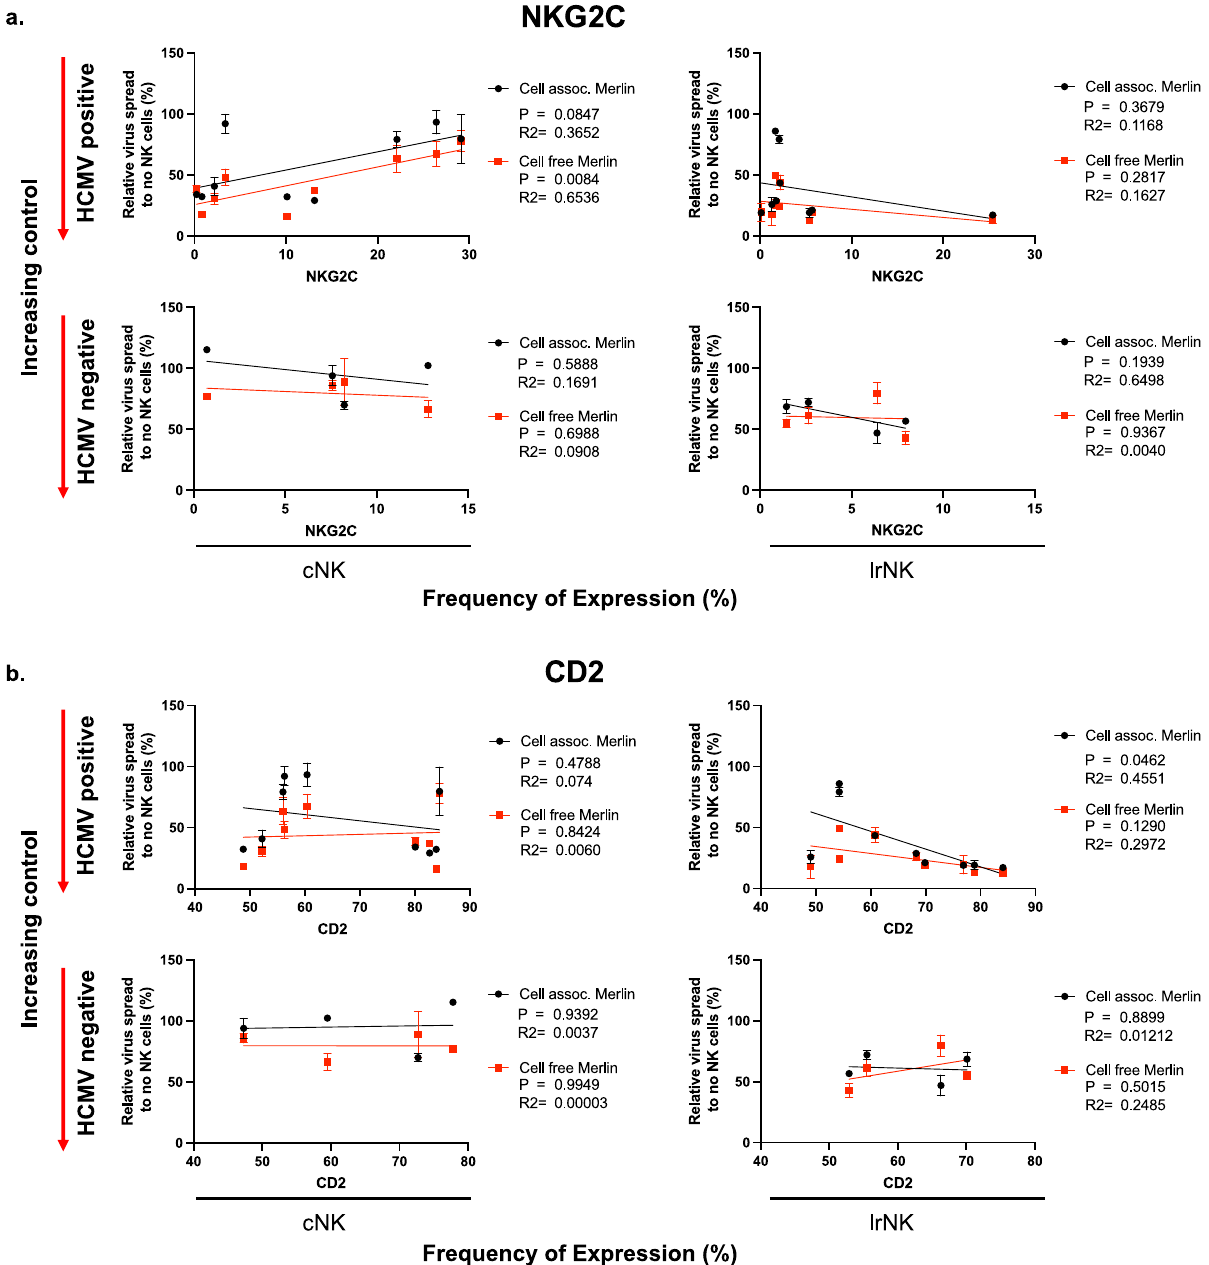
Fig. 3 | Control of cell-associated HCMV by lrNK cells directly correlates with frequency of CD2+cells in seropositive individuals. In vitro control of HCMV strains(Cellassoc.merlin-Black,CellfreeMerlin-Red)bycNKandlrNKfromHCMV seropositiveindividuals(Toprows; n =9)andseronegative(Bottomrow; n =4)was